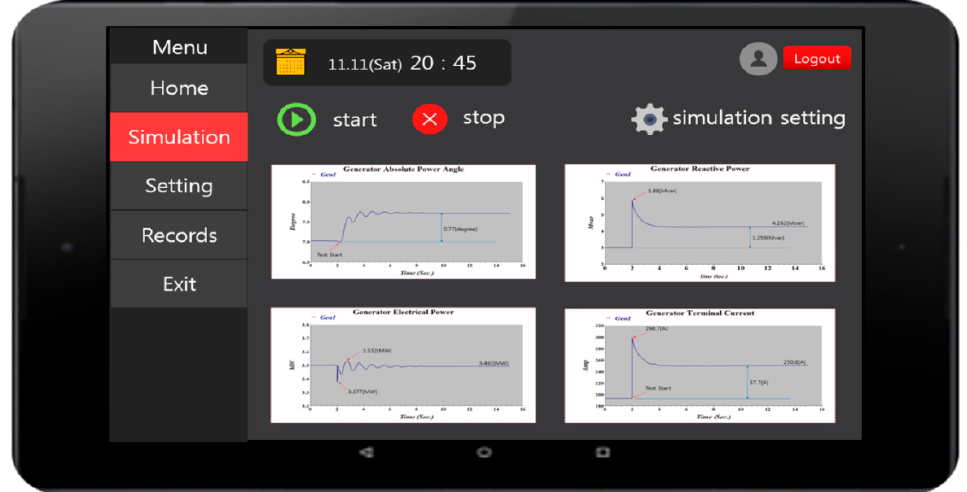
Figure 36. The Android-based environment monitoring application for an excitation system.